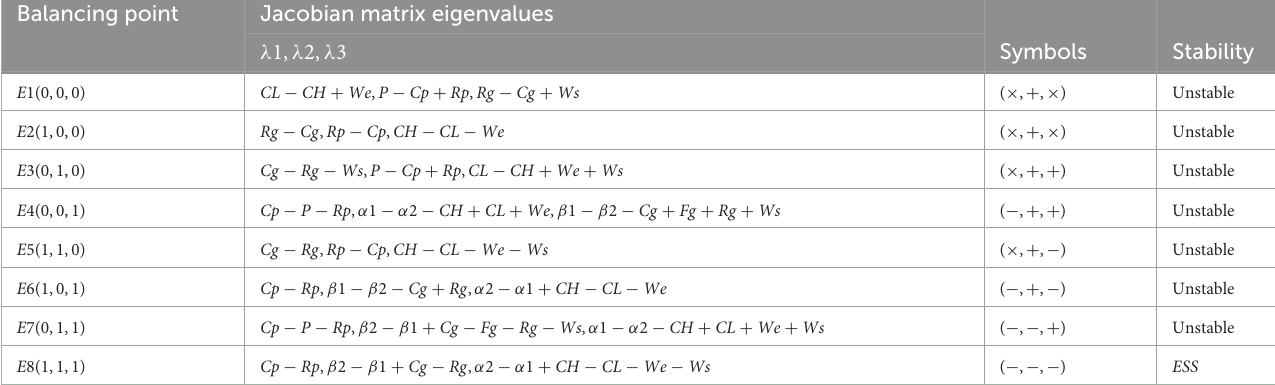
TABLE 3 Equilibrium point stability